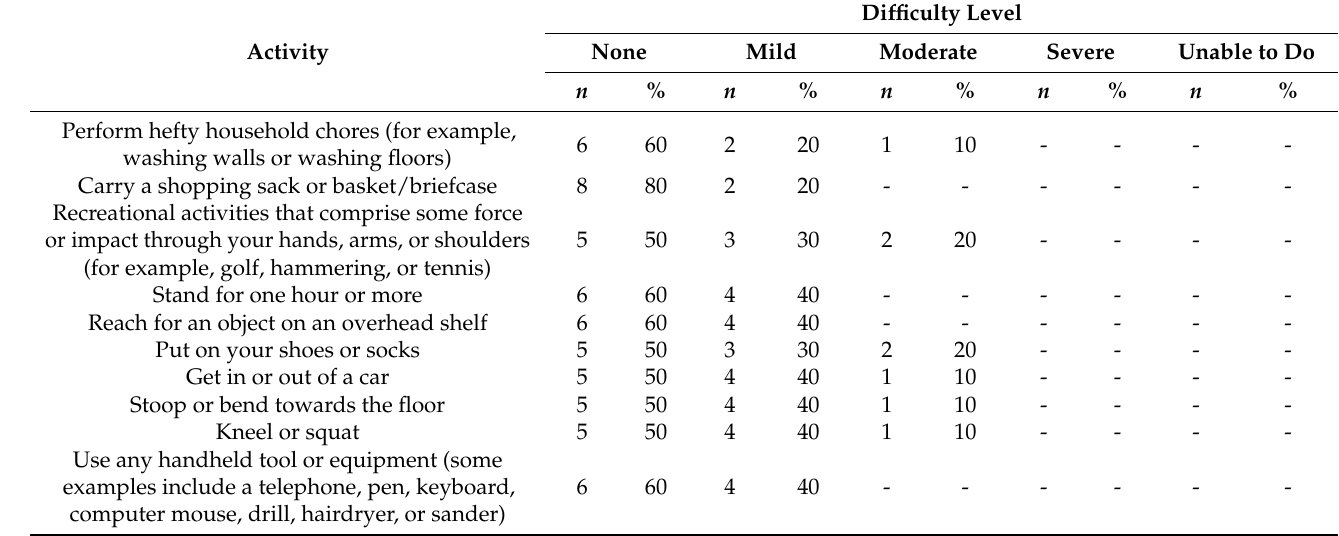
Table 4. Functional limitations to perform activities of daily living (ADLs) among construction